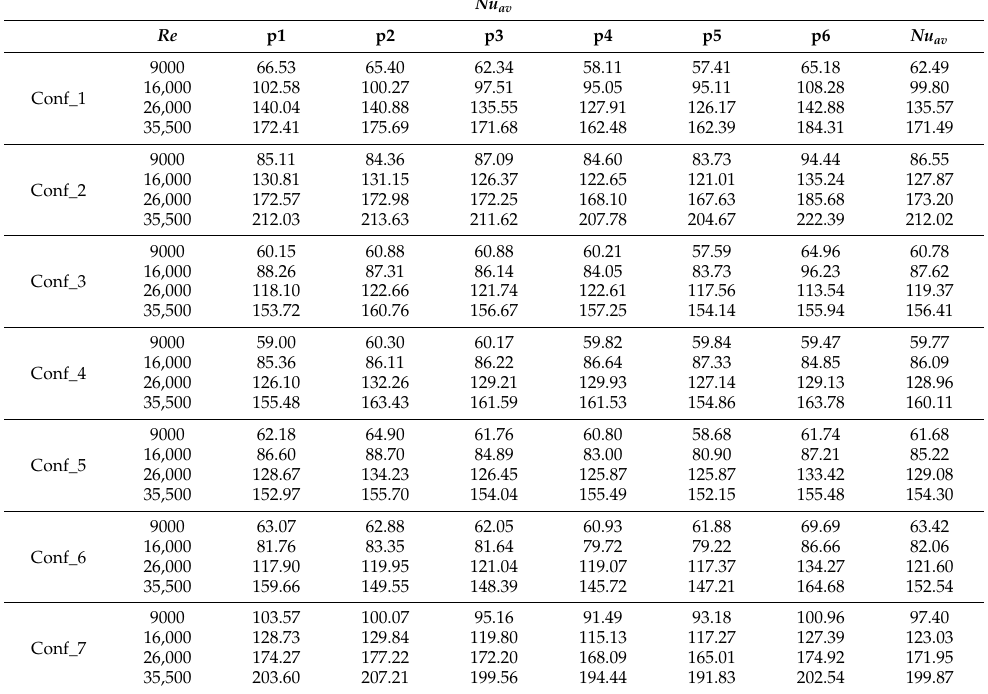
Figure 12. Local Nusselt numbers distribution for P/e = 11, configuration_1 and p4 mid-section. Table 1 shows the local values of the Nusselt number for various geometries and measurement section from p1 to p6, as well as the average values for the whole plate for various Reynolds numbers. Table 1. Values of averaged Nusselt numbers ( Nu av ) for six measuring sections (p1, p2, p3, p4, p5, p6) and averaged for the whole